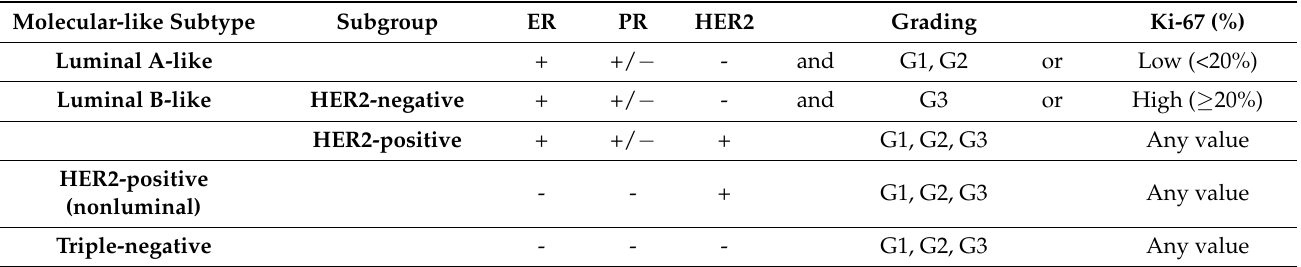
Table 2. Molecular-like subtyping of invasive breast cancer using ER, PR, HER2, and Ki-67 expression and tumor grade